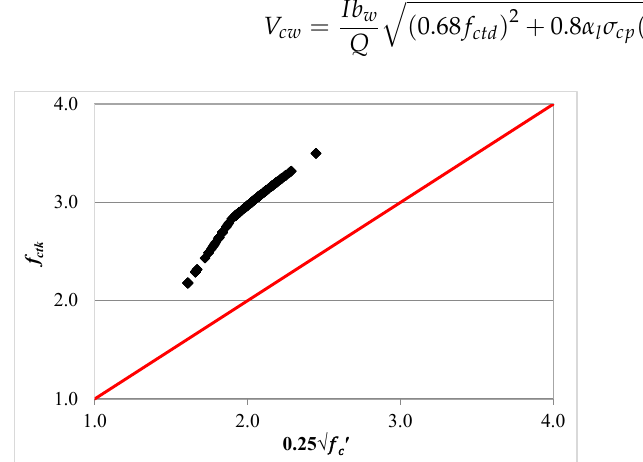
(cid:112) f (cid:48) c . Figure 15. Calculated tensile strength of the concrete f